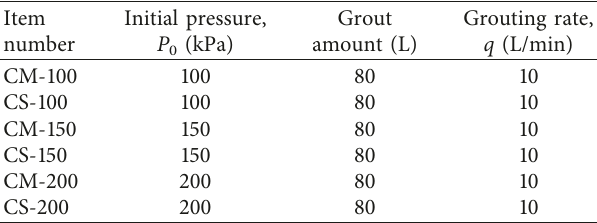
Table 1: Number of experiments and their parameters.